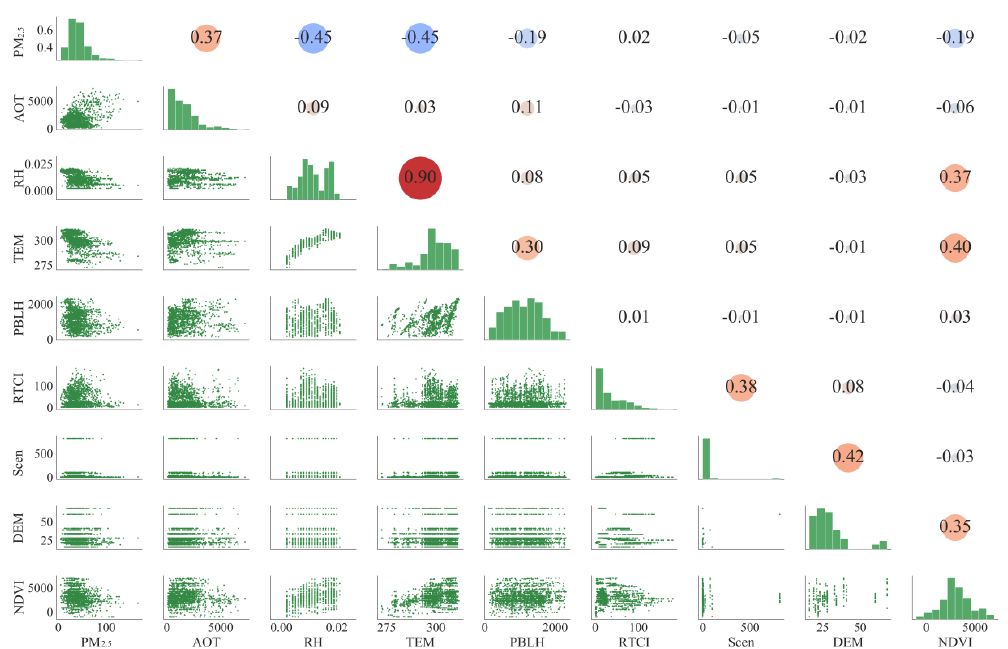
Figure 5. Diagram of the composite analysis matrix. The diagonal line of the matrix shows the histogram of the frequency distribution of each variable; the lower triangle shows the bivariate scatter plots; the upper triangle indicates the Pearson’s correlation coefficient between the two variables. Only parts of the variables are presented due to the page limit (composite analysis matrixes for the Sample set A and Sample set B are provided in Supplementary Material: Figures S1 and S2). “RTCI” means real-time check-in variable; “PBLH” means planetary boundary layer height; “TEM” means air temperature at a 2-m height; “RH” means specific relative humidity; “Scen” means the cleaner location type